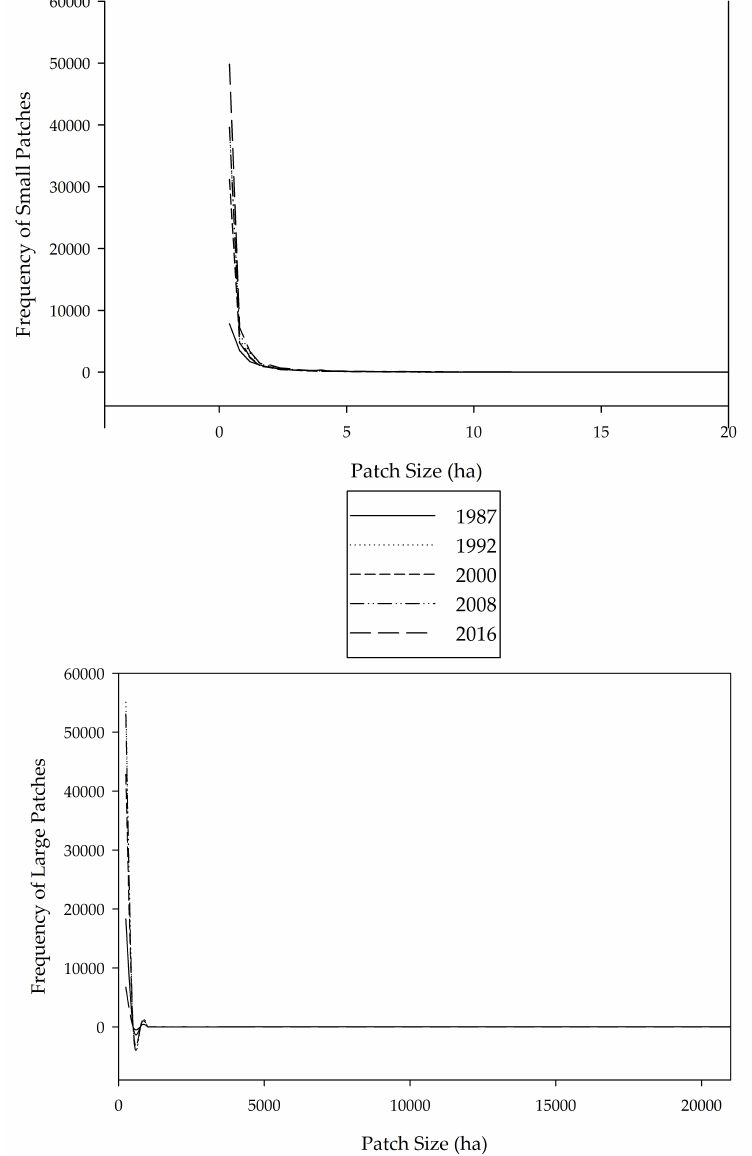
Figure 4. Comparison of the frequency distribution for 98% of small ( < 20 ha) and large ( < 21,300 ha) woody patches from 1987 to 2016 in the Rio Grande Delta and surrounding rangeland study area (10,065 km 2 ) in South Texas, United